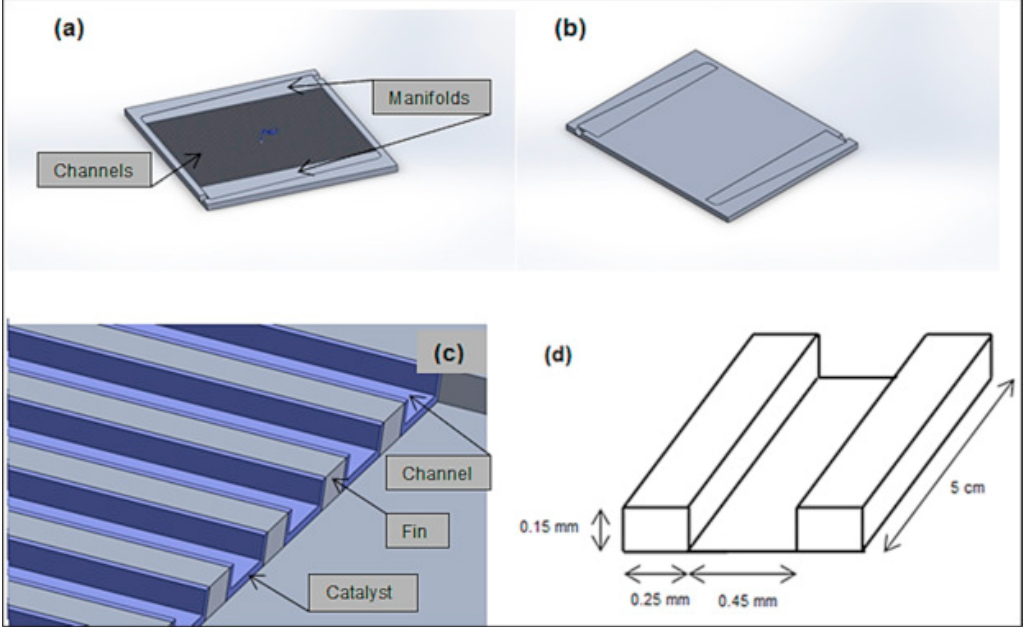
Figure 1. ( a ) 3D schematic of a platelet containing 80 microchannels and fluid distribution manifoldS; ( b ) Platelet with manifold only; ( c ) Enlarged view of the first five microchannels of the platelet ( d ) Sizes of the microchannel without catalyst layer [6].